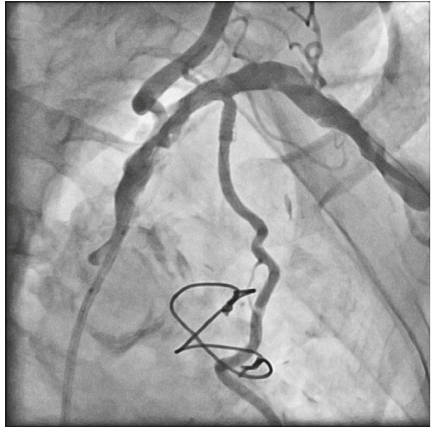
Figure 5: Final angiogram demonstrating a patent SA/LIMA bifurcation. SA, subclavian artery; LIMA, left internal mammary artery.